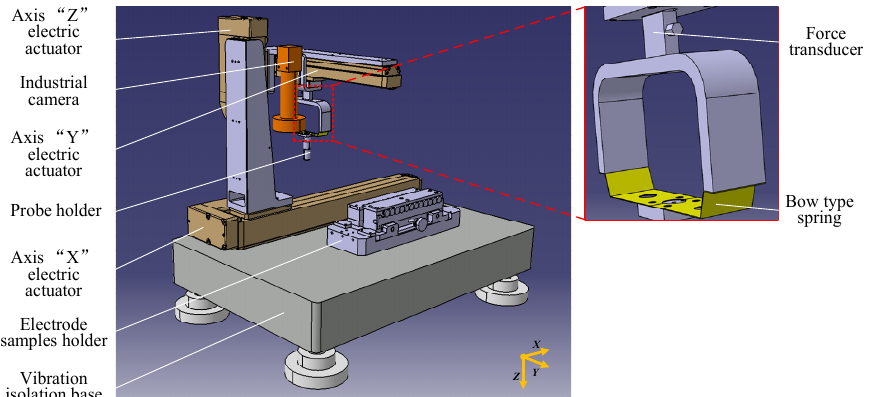
Figure 2. Three-dimensional (3D) model of the mechanical structure.